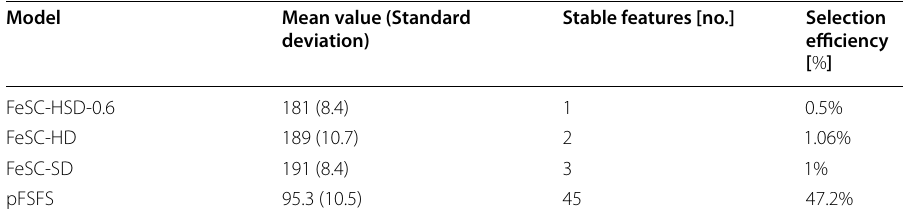
Table 5 Selected and stable features in the LH dataset